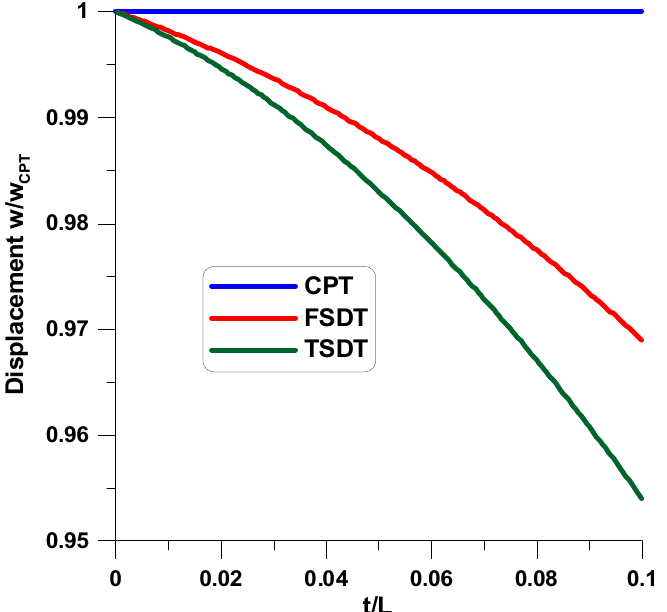
Figure 7. Variations of the clamped plate maximal deflections for different approximations of de- formations.